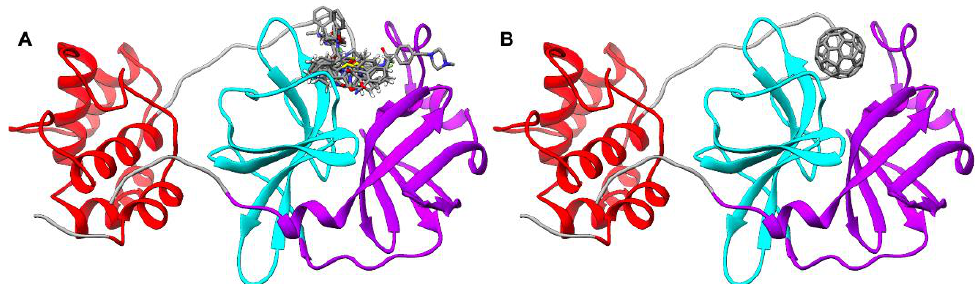
Figure 2. ( A ) Binding of M pro ligands N3 (PDB ID 6LU7), masitinib (PDB ID 7JU7), parampanel analogue compound 5 (PDB ID 7L11), MPI4 (PDB ID 7JQ1), ML188 (PDB ID 7L0D), isofloxythepin (PDB ID 7AY7), carmofur (PDB ID 7BUY), UAW243 (PDB ID 6XFN), and boceprevir (PDB ID 6XQU) in M pro . The protein structure is shown with the ribbon. ( B ) Identification of the fullerene binding pocket in M pro .